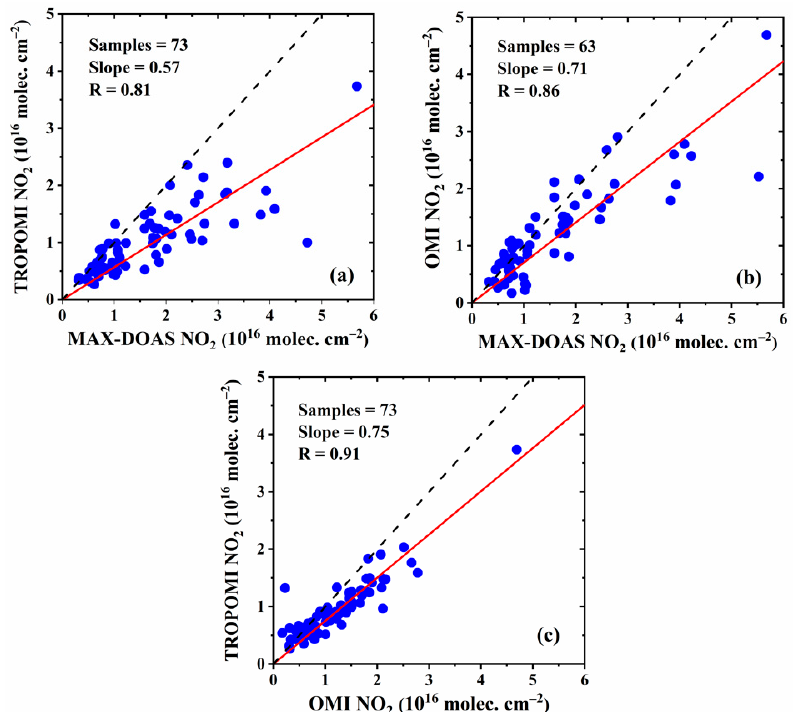
Figure 8. ( a ) Correlation between daily TROPOMI tropospheric NO 2 columns and MAX-DOAS NO 2 observations made from 1 February through 30 June 2018. ( b ) Same as ( a ), but for correlation between OMI and MAX-DOAS. ( c ) Same as ( a ), but for correlation between TROPOMI75 and OMI (units: 10 16 molec cm –2 ).